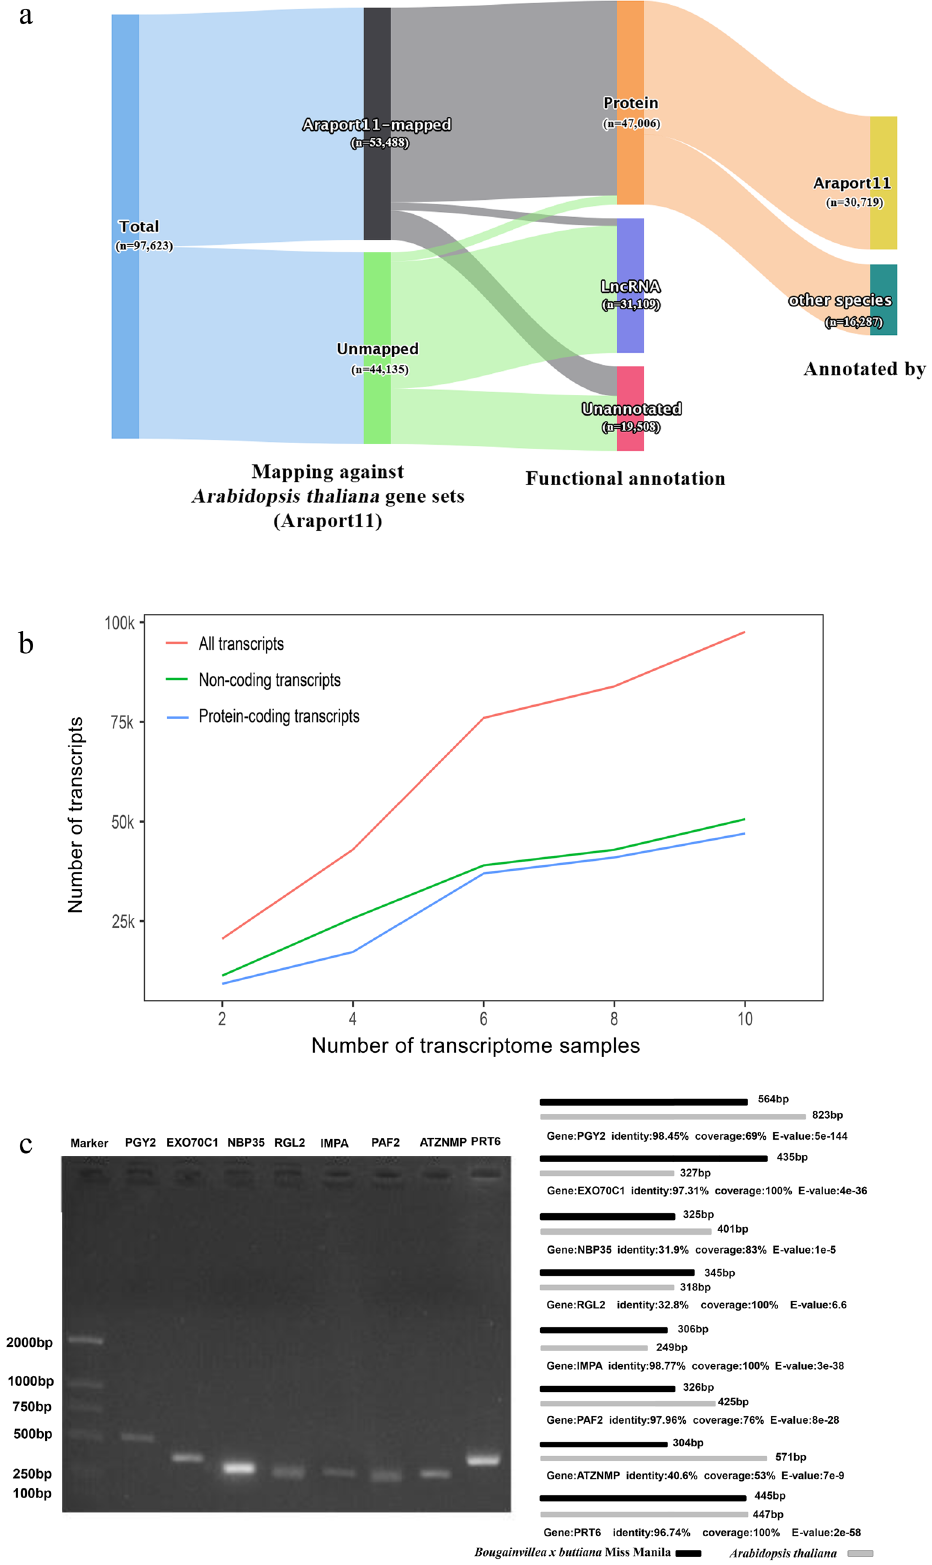
Figure 1. Overview of the integrative transcriptome. ( a ) Functional annotation of the integrative transcriptome. ( b ) The scalability of integrative transcriptome. ( c ) Experimental validation of selected eight transcripts using PCR and Sanger